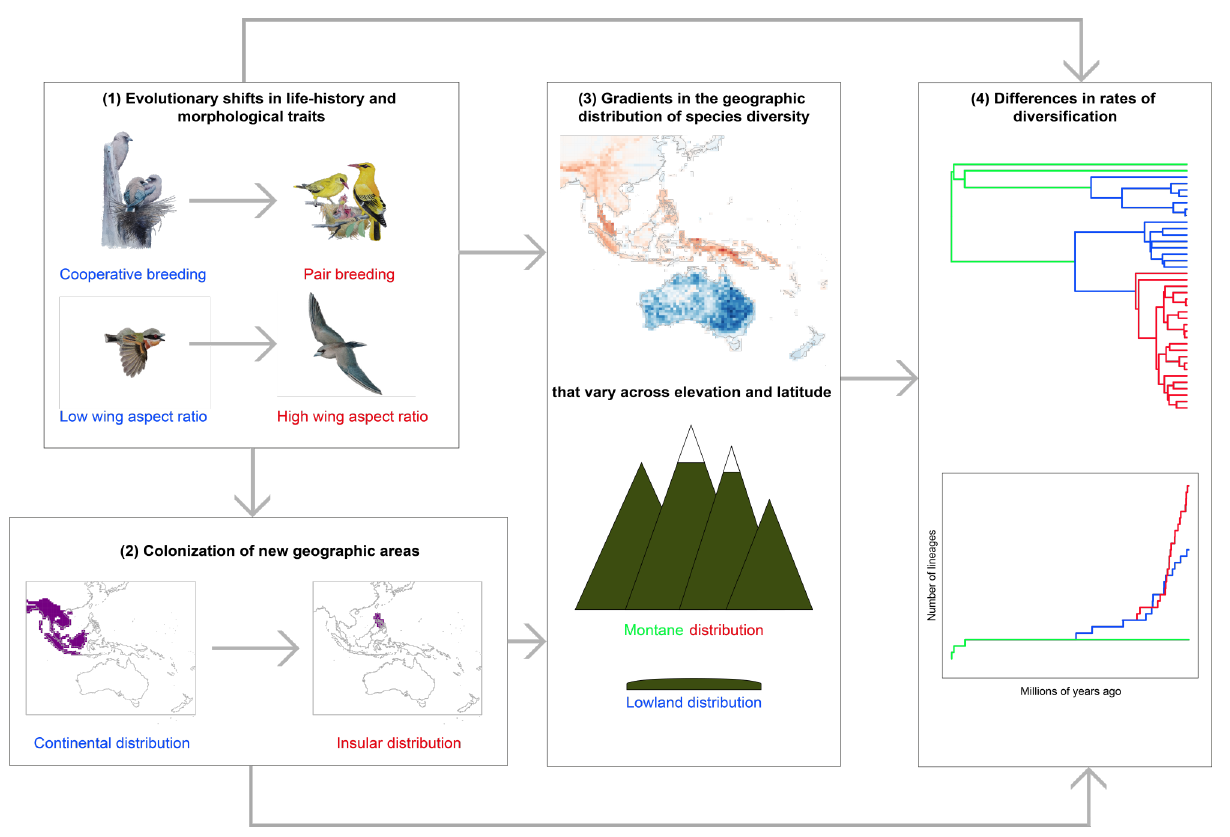
Figure 1. General dynamics of dispersal and diversification among passerine birds. (1) Evolutionary shifts from coop- erative breeding to pair breeding and from wings with low to high aspect ratios simultaneously result in (2) range ex- pansion and the colonization of new geographic areas and (3) spatial gradients in the geographic distribution of spe- cies. These factors lead to different rates of diversification among passerine clades (4). The geographic distributions, life-history and morphological traits highlighted in either red, blue or green are reflected by the diversification dynam- ics presented in the same colour on the phylogeny and LTT plot in (4). Jon Fjeldså kindly provided all